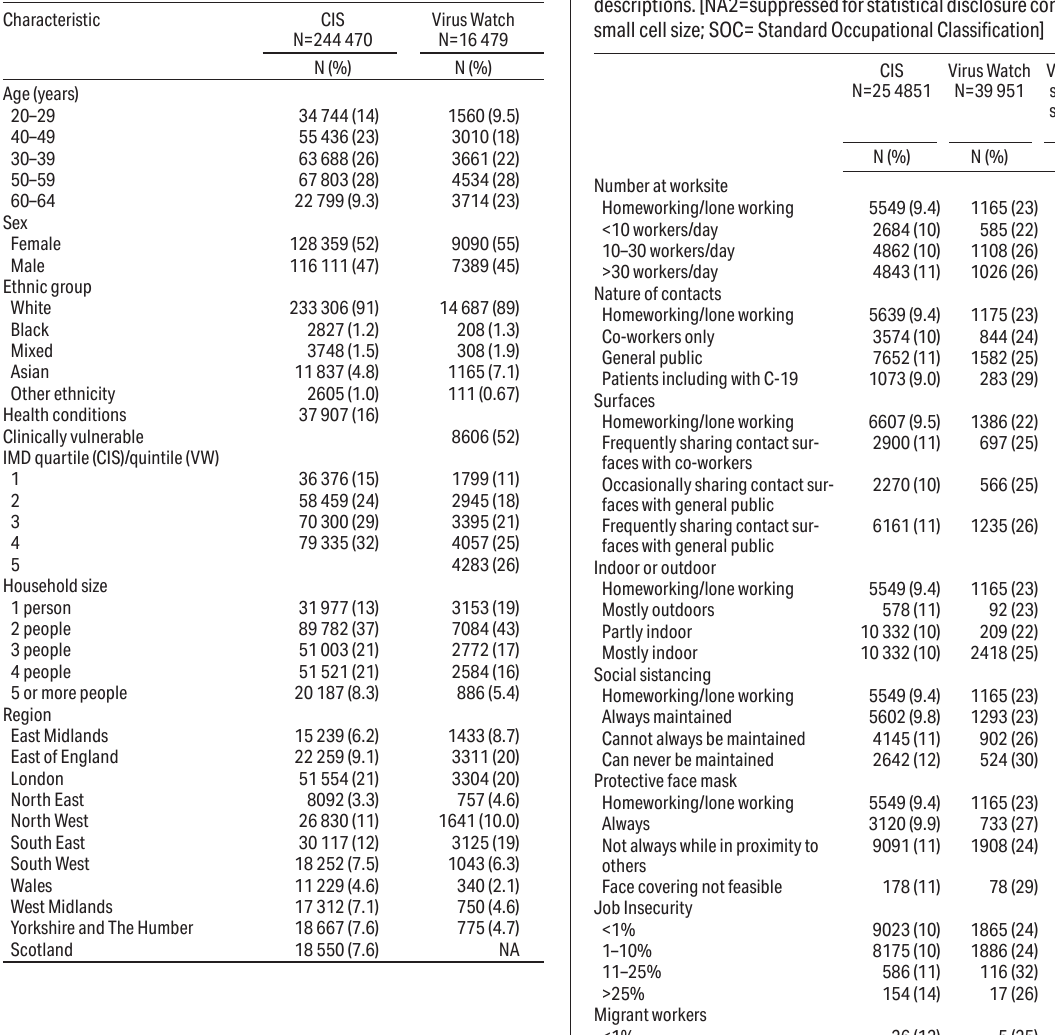
Table 2. Demographic characteristics of workers participating in the COVID-19 Infection survey (CIS) and Virus Watch. [IMD= index of mul- tiple deprivation.]